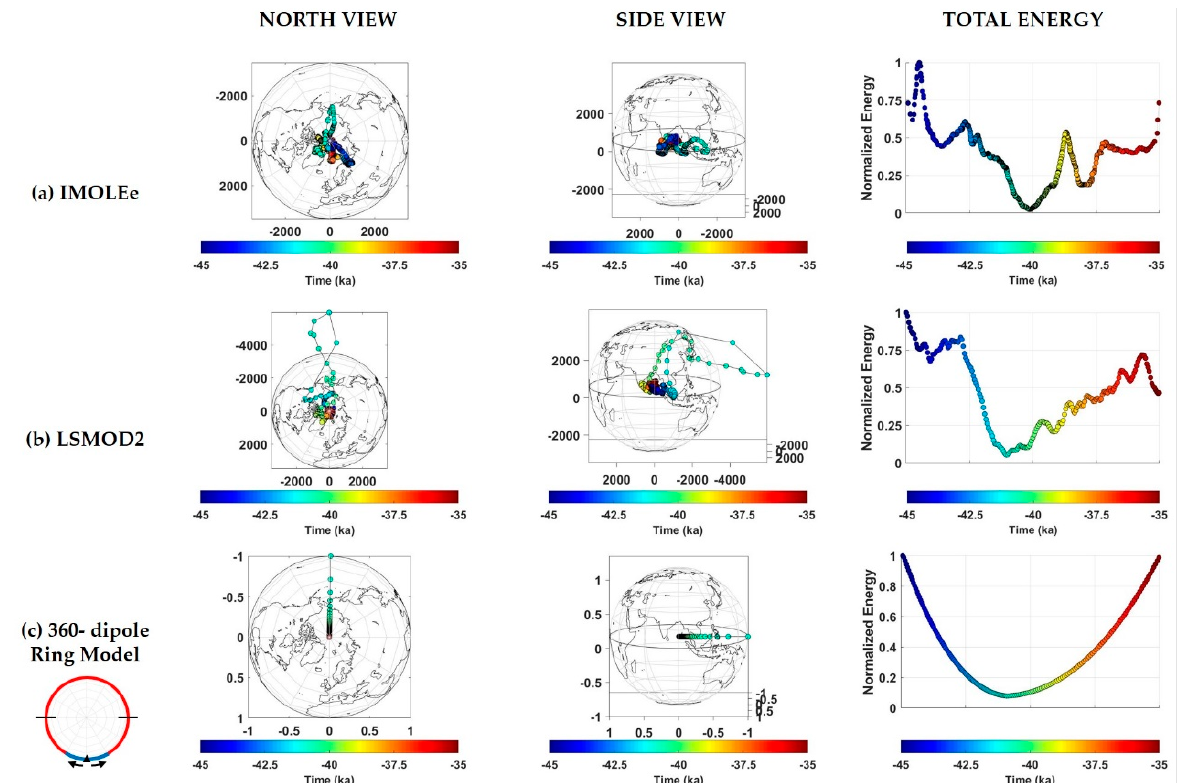
Figure 3. Evolution of the ED and the normalized total energy for the Laschamp excursion according to ( a ) IMOLEe paleoreconstruction (position in km); ( b ) LSMOD.2 paleoreconstruction (position in km); and ( c ) the 360-DRM proposed in this paper. Blue/red circumference indicates the first dipoles to change their polarity (black triangle), the propagation directions (black arrows), and the limits of the reversing regions (black lines). Note that in ( c ) the evolution of the ED is dimensionless. Coastlines are plotted only for longitude reference (note they are projected on a sphere of arbitrary radius).